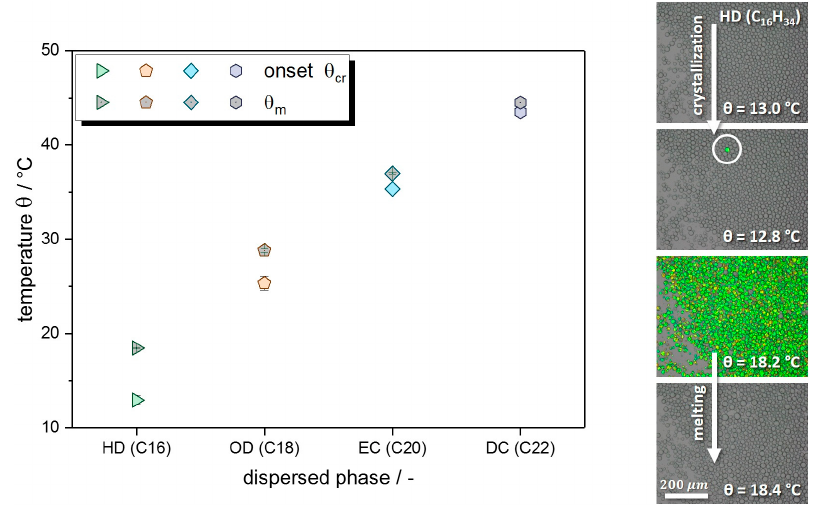
Figure A2. Onset crystallization temperature onset ϑ cr , dispersion and melting point/ temperature ϑ m , dispersion of the alkane dispersions. Micrographs on the right show one of three exemplary determination of onset crystallization temperature and melting point in hexadecane dispersions. Length of the scale bar is 200 µm.